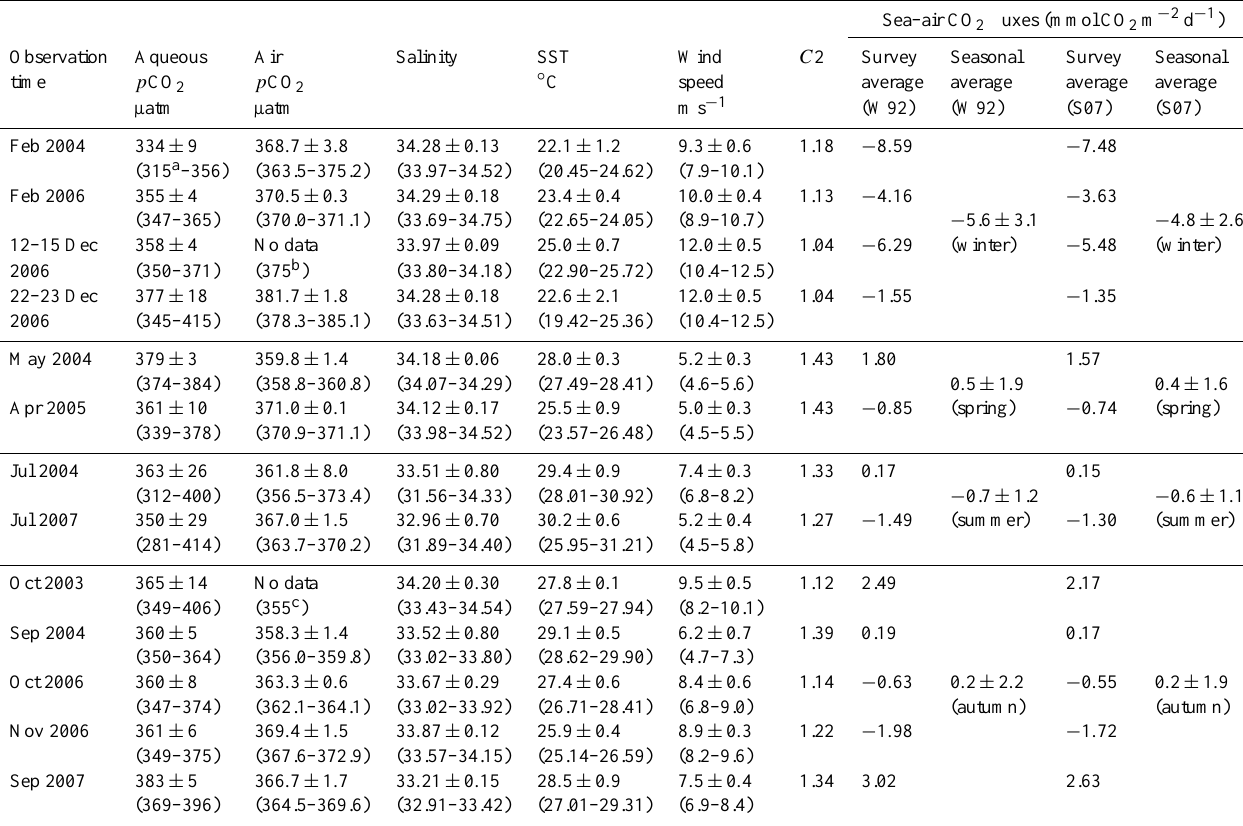
Table 3. Summary of p CO 2 , salinity, and SST along cruise tracks, monthly satellite-derived wind speed, and sea–air CO 2 flux estimation in domain A. The annual sea–air CO 2 flux amounts to − 0.44 ± 0.65molm − 2 yr − 1 using the S07 equation or − 0.51 ± 0.75molm − 2 yr − 1 using the W92 equation. Note that C 2 is the nonlinearity effect of the short-term variability of wind speeds over a month on the gas transfer velocity, assuming long-term winds followed a Raleigh (Weibull) distribution (Wanninkhof, 1992; Jiang et al., 2008). See text for details. Errors in sea–air CO 2 flux estimation are the temporal variability of CO 2 fluxes based on respective